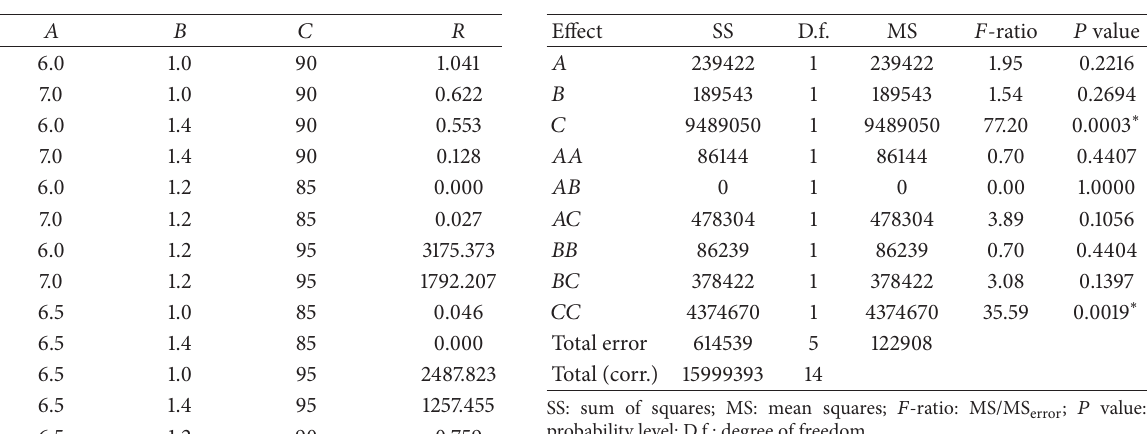
Table 2: Experimental design matrix and the responses for BBD. Table 3: ANOVA results for optimization by BBD.